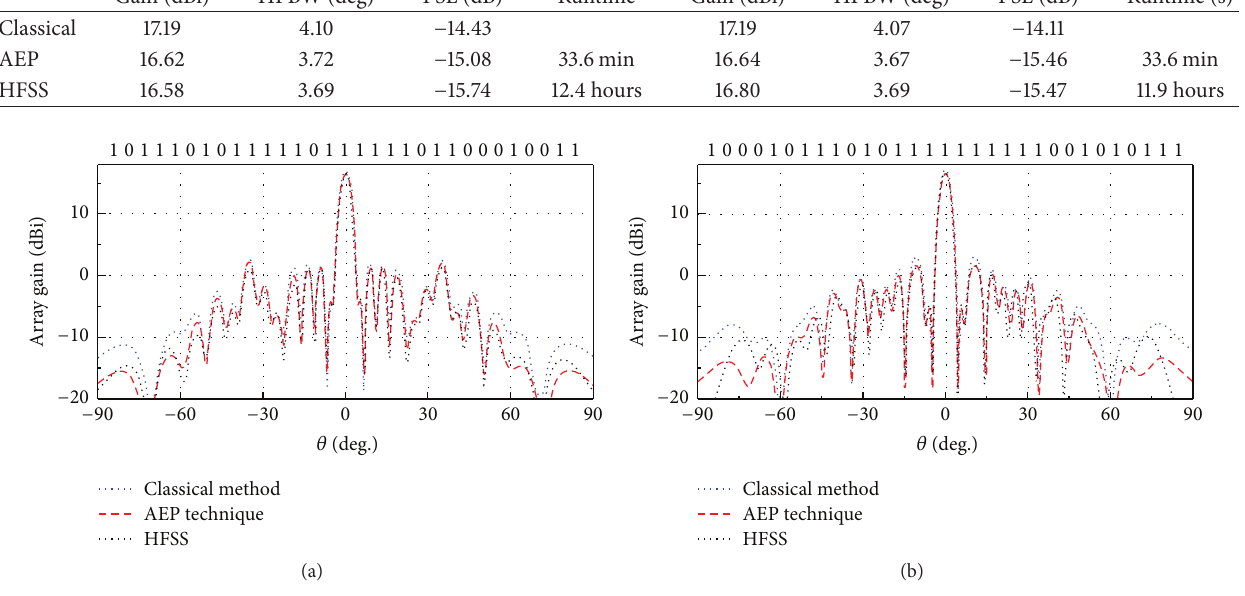
Figure 4: Gain patterns of the planar thinned arrays. (a) Thinned array 1. (b) Thinned array